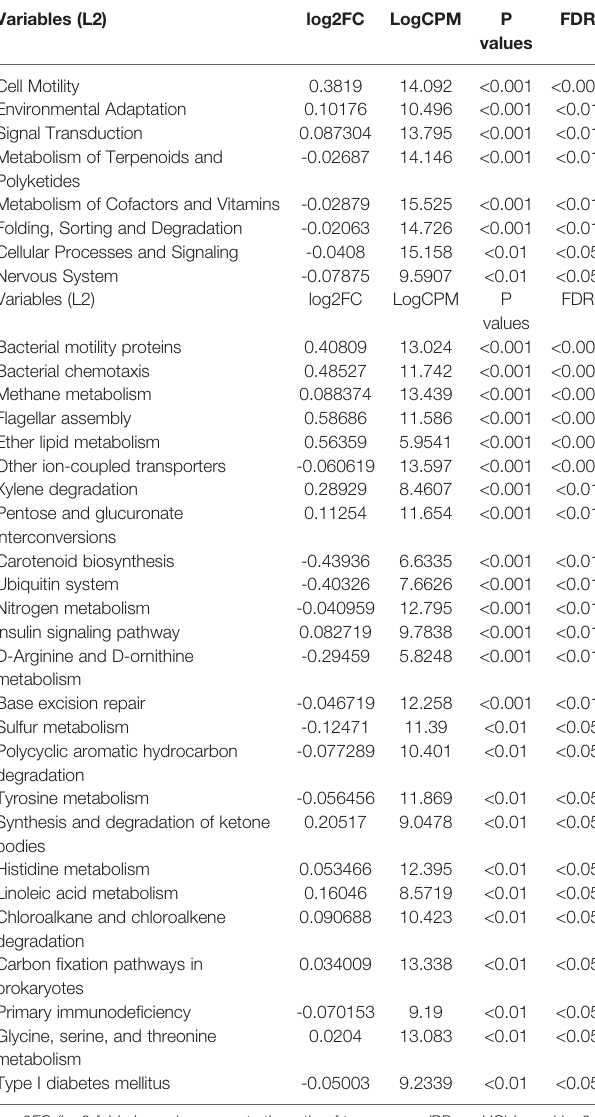
Log2FC (log2 fold change) represents the ratio of two groups (PD vs. HC) based log2. LogCPM (log counts per million) represents the expression level of variables. FDR is the false discovery rate as correction of P